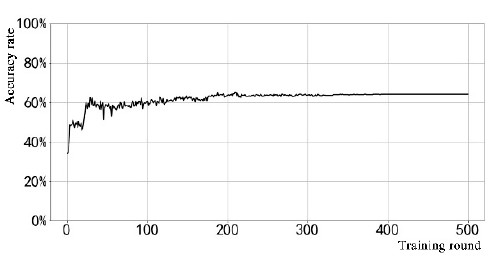
Figure 30. Loss function curve.